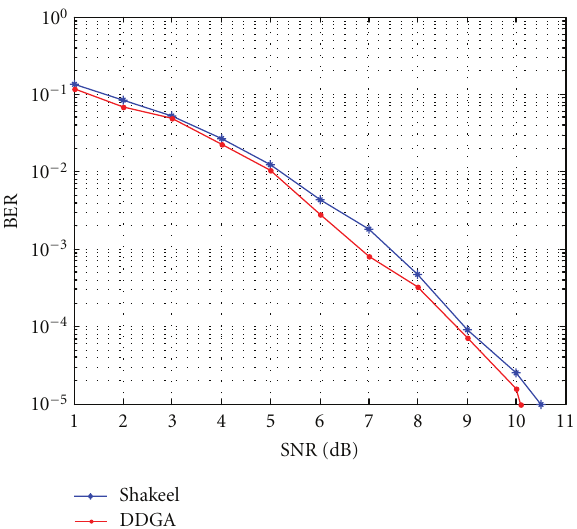
Figure 24: Performances of DDGA, and Shakeel algorithms for BCH (31,26,3) code over RC.